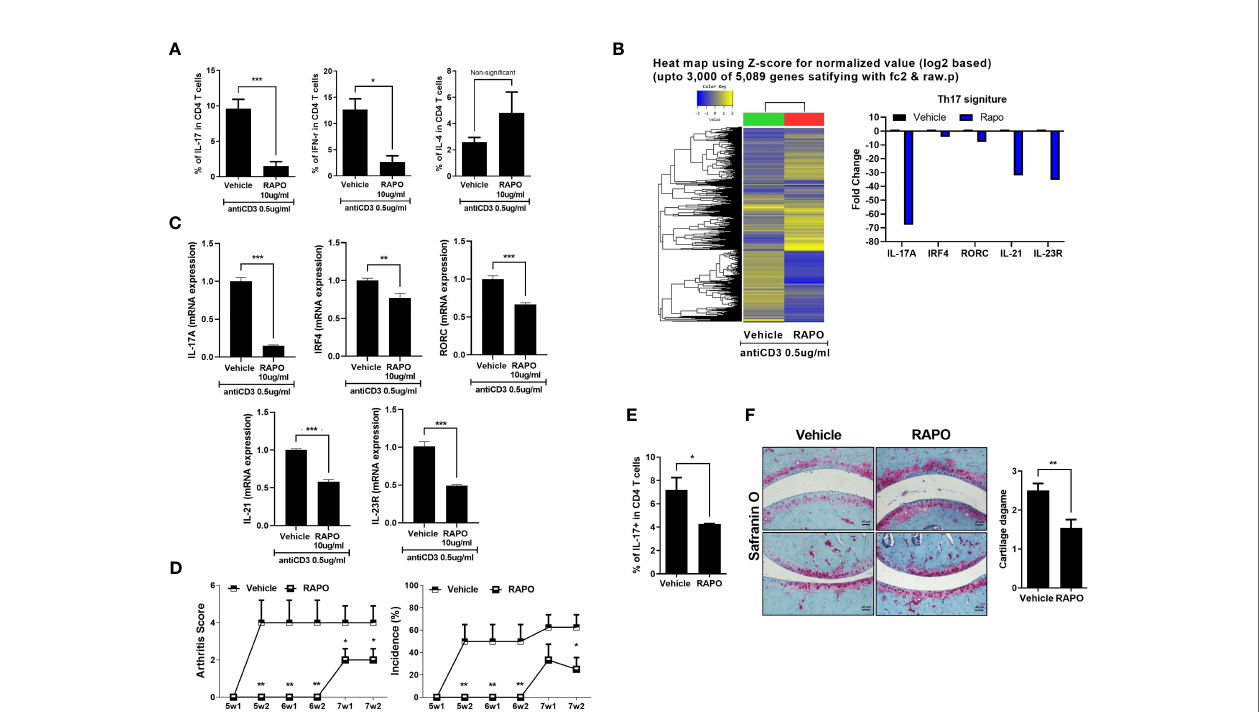
FIGURE 6 | Effects of Bi fi dobacterium longum RAPO in human PBMCs and avatar mice of RA patient. (A) The PBMCs of the RA patient were cultured with anti- CD3 antibody for 72 h and the resulting Th1 cells (IFN-r + CD4 + ), Th2 cells (IL-4 + CD4 + ), and Th17 cells (CD4 + IL17 + ) were analyzed. (B) The PBMCs of the RA patient were cultured with anti-CD3 antibody for 48 h. Hierarchical cluster heatmap of the PBMC-stimulated anti-CD3 antibody of RA patient treated with B. longum RAPO or vehicle. The expression of Th17 pathway was analyzed by RNA sequencing. Signi fi cantly differentially expressed gene and signi fi cant differences in Th17 pathway activities. The fold change of Th17-related genes decreased in the treatment of the B. longum RAPO. (C) Relative mRNA expression of Th17 pathway genes was analyzed by real-time PCR. (D) NSG mice were administered with B. longum RAPO (1 × 10 8 CFU/mouse) once daily for 7 weeks after the sensitization injection. (E) Splenocytes from the avatar mice of RA patient treated with B. longum RAPO. The cells were stained with Abs against CD4, IL-17. A graph from a representative experiment showing the frequency of IL-17 + cells in CD4 T cells. (F) Joint sections from the avatar mice of RA patient with B. longum RAPO-treated mice were stained with safranin O. * p < 0.05; ** p < 0.01; *** p < 0.001 ( vs . vehicle-treated